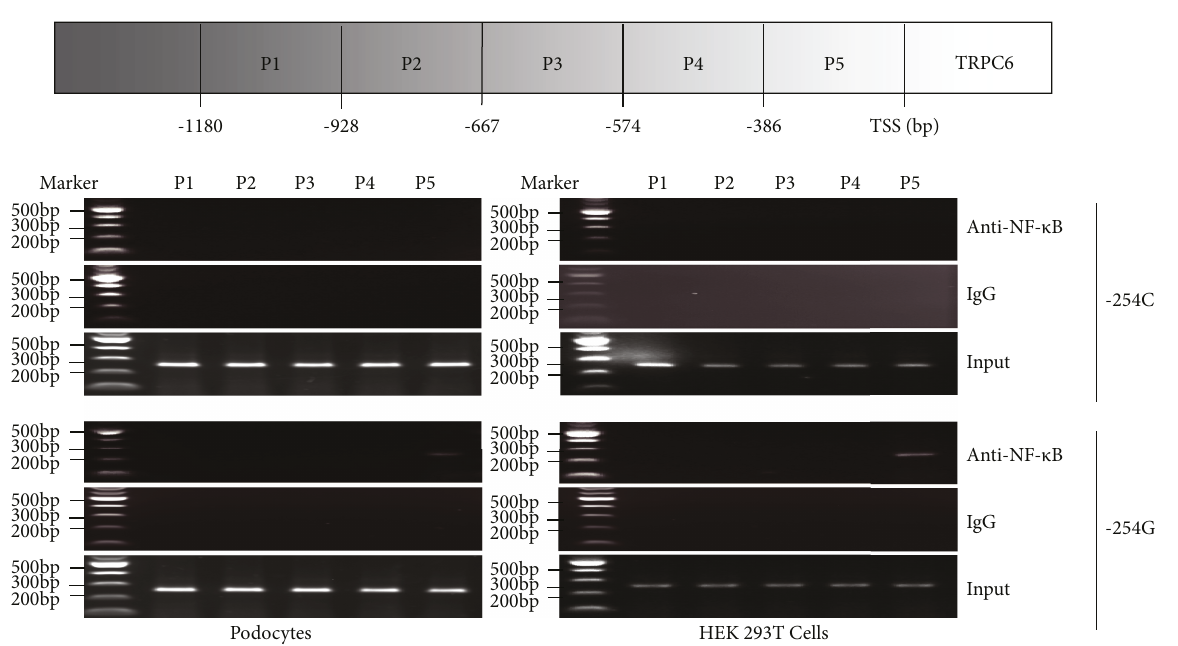
Figure 2: Di ff erential analysis of the binding of the transcription factor NF- κ B to the TRPC6 promoter region in podocytes and HEK 293T cells using ChIP-PCR. Five primers were designed to amplify di ff erent DNA fragments residing in the desired promoter region of the TRPC6 gene (shown as P1-5), and the DNA-protein complex (with − 254C or G allele) was precipitated using negative control IgG or antibodies against NF- κ B. Both in podocytes and HEK 293T cells, NF- κ B was bound to the TRPC6 promoter with − 254G (P5), while no binding was found in the normal sequence. TSS: transcription start